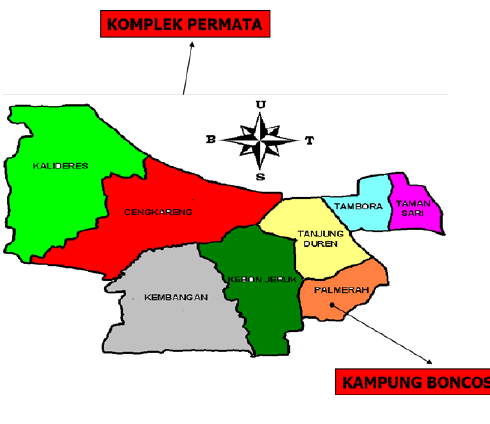
Map of Areas Prone to Narcotics